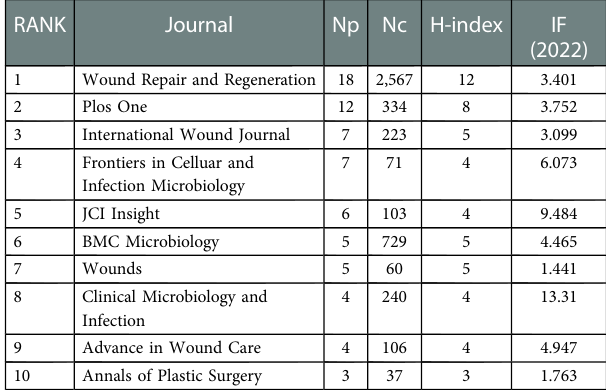
TABLE 2 The top 10 most productive journals about HTS associated with chronic wound.